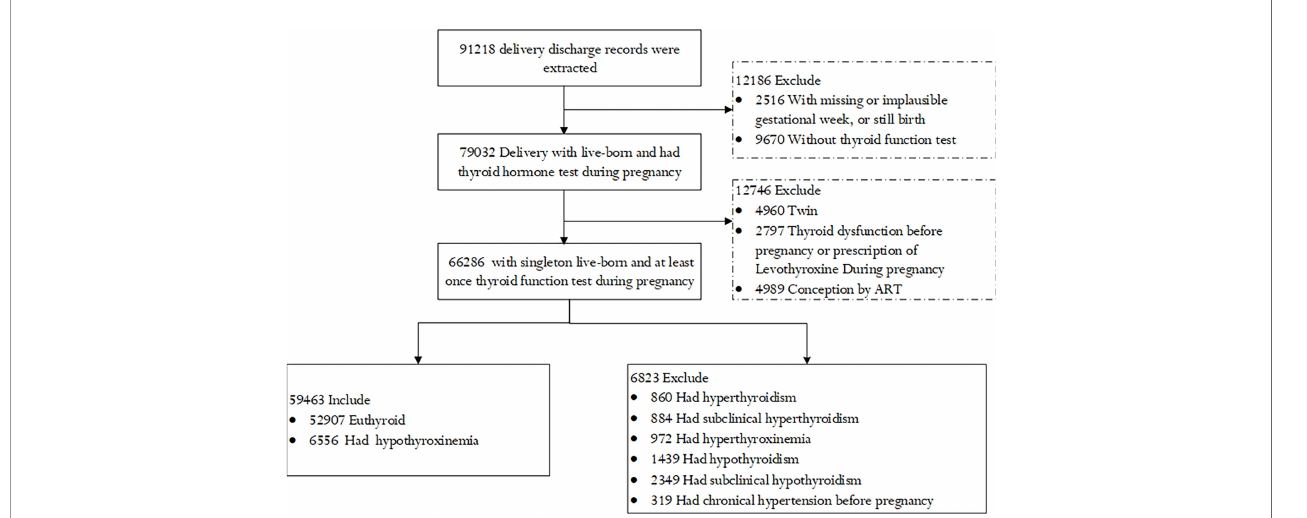
FIGURE 1 | Flowchart of the study